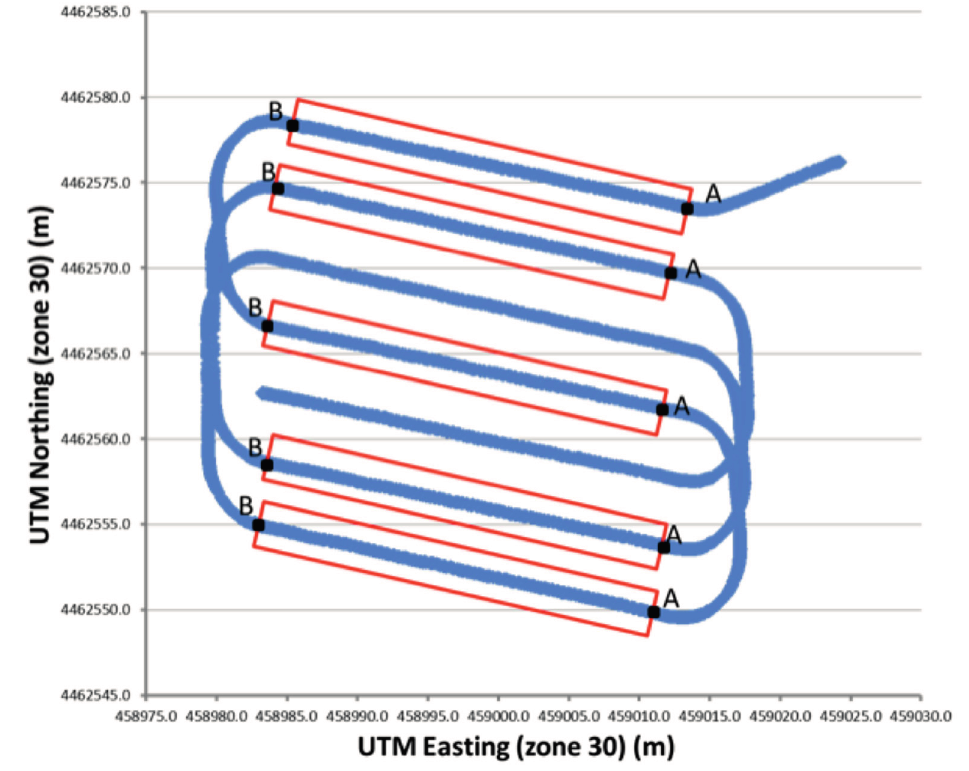
Figure 5. Straight-line path for the autonomous